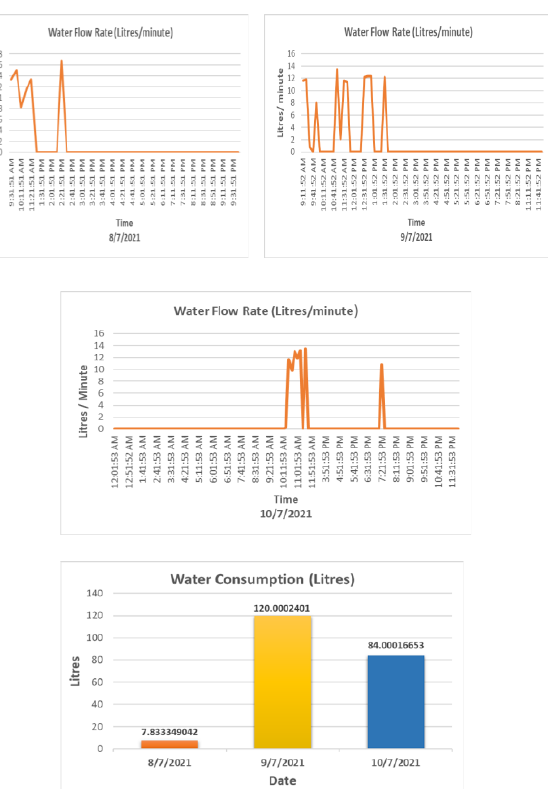
Figure 17. Data of water flow rate in three